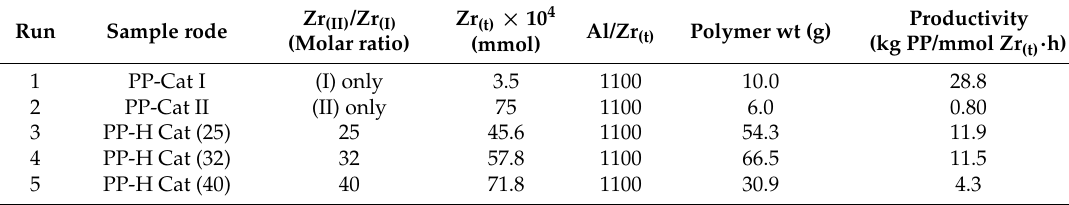
Table 1. Polymerization results of catalysts (I) and (II) and their binary systems.